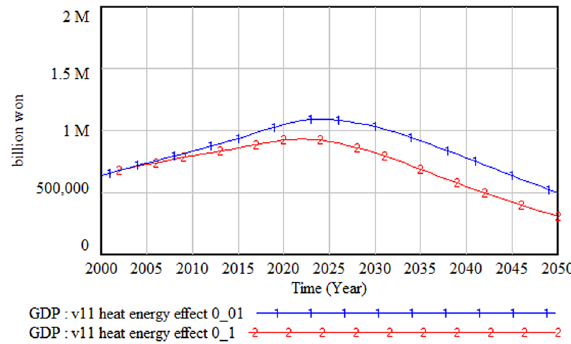
Figure 28. Impact of heat waves on gross domestic product (GDP).